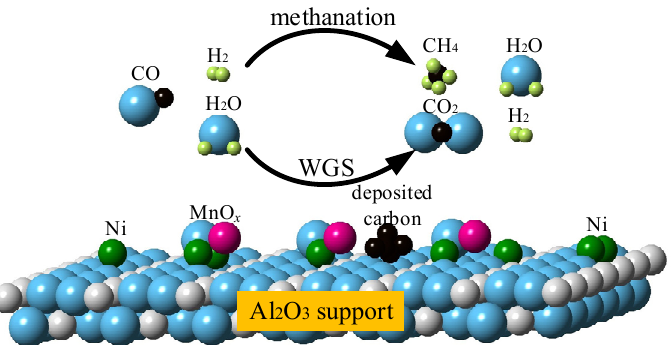
Figure 13. Schematic of the synergy effect between Ni and MnO x species for partial methanation coupling with WGS.